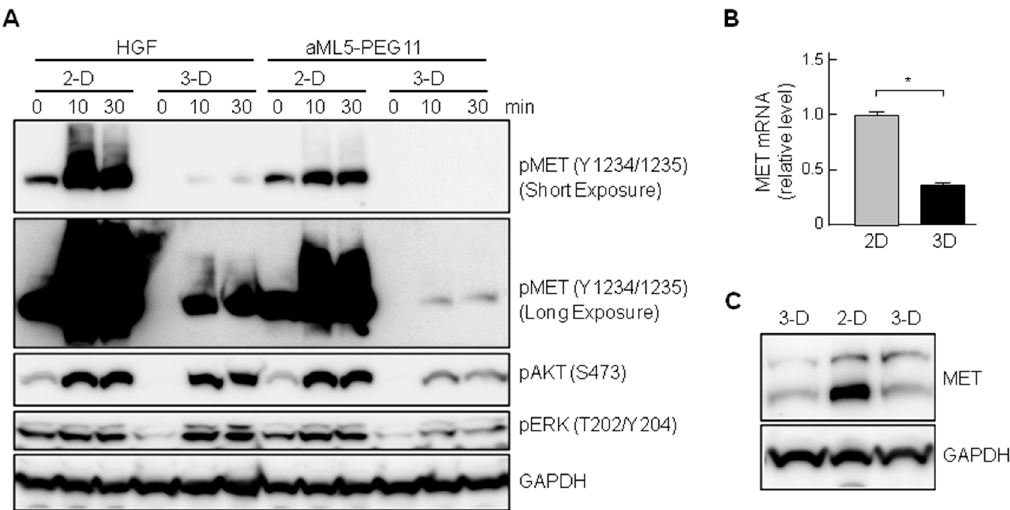
Figure 6. Changes in the activation and expression levels of MET receptors in 2-D and 3-D culture conditions. ( A ) Changes in MET, AKT, and ERK phosphorylation. HuCCT1 cells were cultured under 2-D (conventional monolayer on culture plate) or 3-D (in collagen gel) conditions and treated with 100 nM aML5-PEG11 or 3.3 nM HGF. Phosphorylation of the MET receptor at Try 1234/1235, AKT, and ERK was detected by Western blotting. GAPDH was monitored to ensure equal loading. ( B ) Changes in MET mRNA expression levels. HuCCT1 cells were cultured under 2-D or 3-D conditions for 24 h. MET gene expression was analyzed by quantitative RT-PCR. Each value indicates the mean ± SD of duplicate measurements. The asterisk indicates a significant difference ( p < 0.05). ( C ) Varying MET protein levels under 2-D and 3-D culture conditions. HuCCT1 cells were cultured under 2-D or 3-D conditions for 24 h. MET receptor levels were detected by Western blotting.